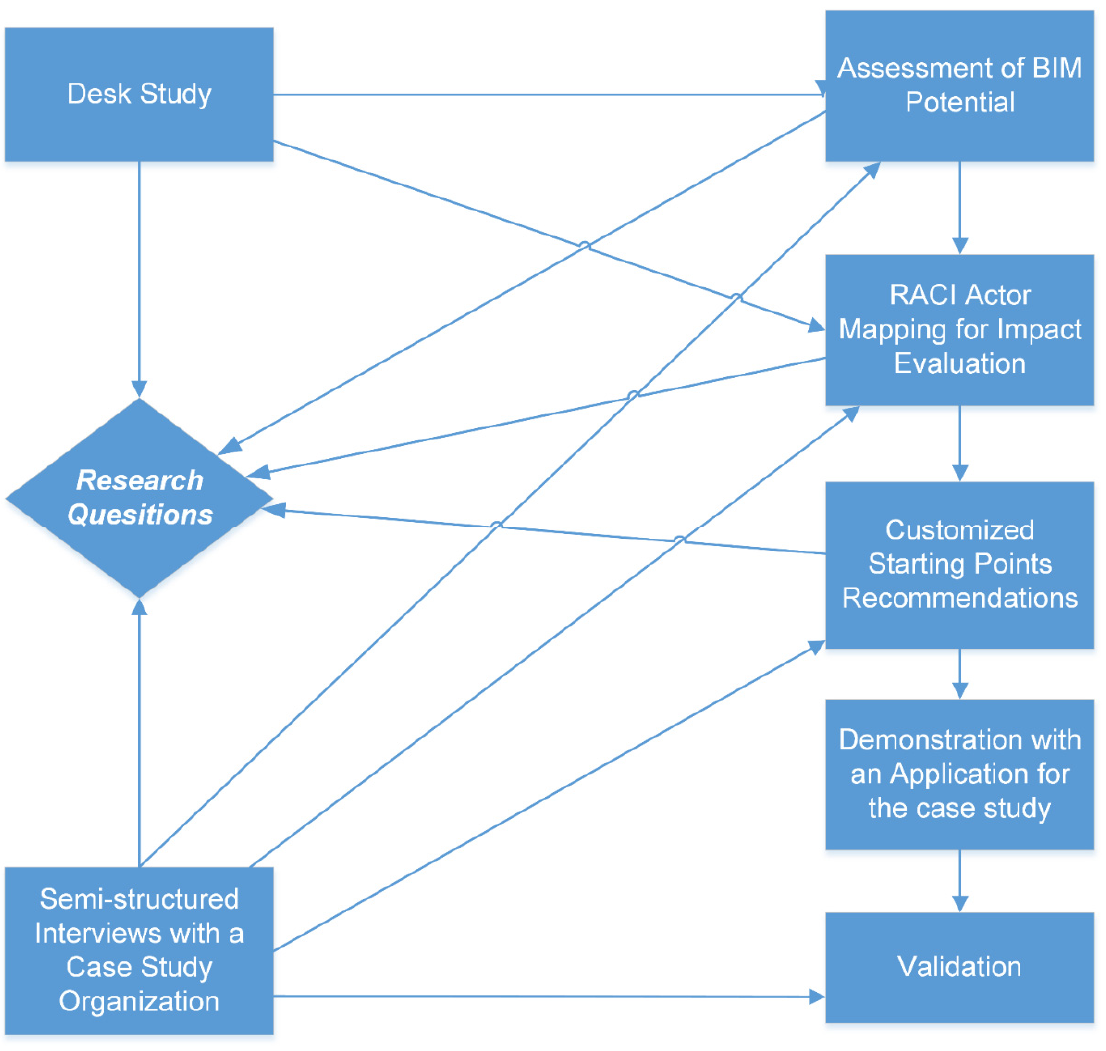
Figure 2. Methodology framework.